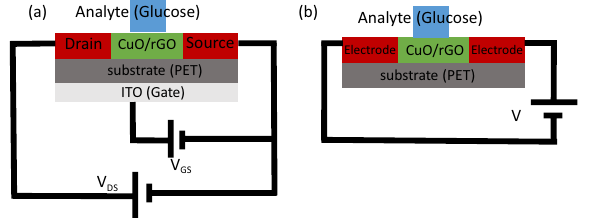
Figure 2. Schematic of the proposed flexible back-gate glucose sensor, ( a ) transistor mode. ( b ) Resistive